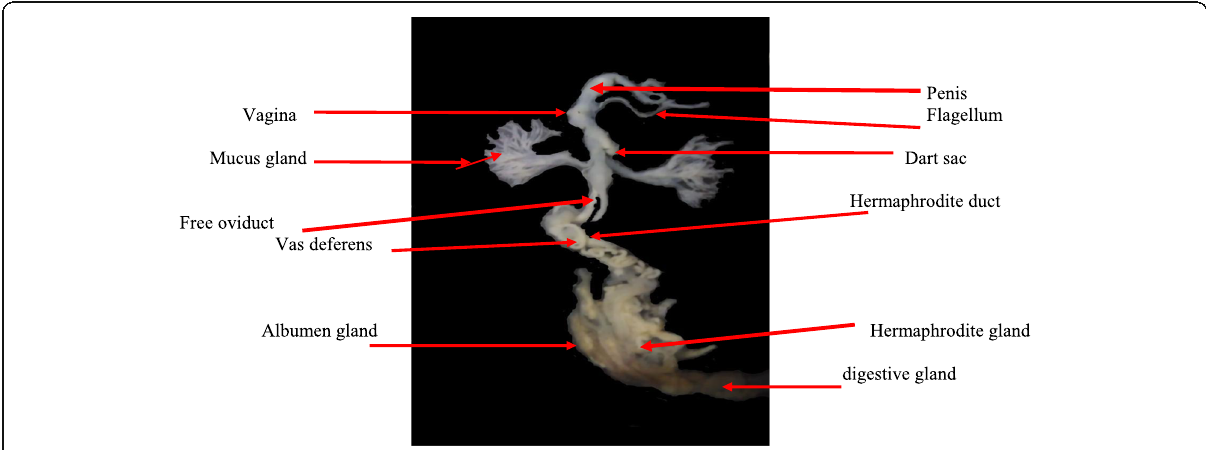
Fig. 1 Reproductive system of land snail, Eobania vermiculata treated with